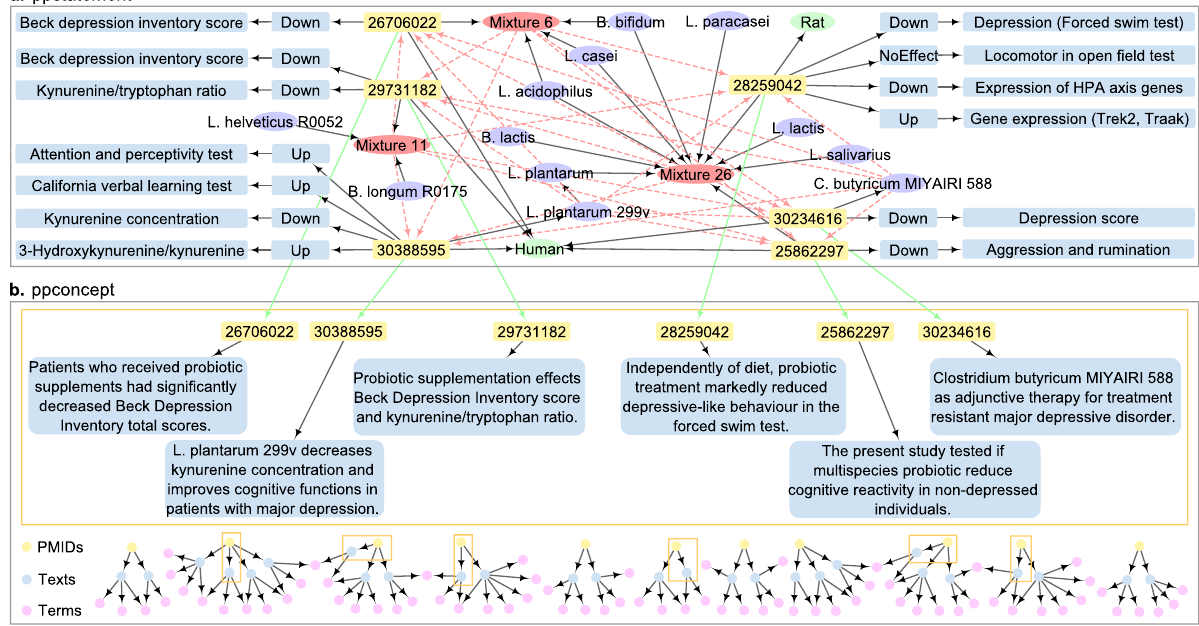
Figure 10. The returned results of probiotics’ effects on depressive disorder by query case 4, of which the code is reproduced in SI Listing 4: ( A ) Assertions from six papers in ppstatement; ( B ) PMIDs in ppconcept overlapping with ppstatement, and associated paper-texts. The bottom part indicates 333 further relevant texts in ppconcept, which do not overlap with ppstatement. Green ellipses: model organisms; purple ellipses: probiotic strains; red ellipses: probiotic mixtures; yellow rectangles: PMIDs; green lines: same PMIDs; black lines: direct relations; red lines: indirect relations between